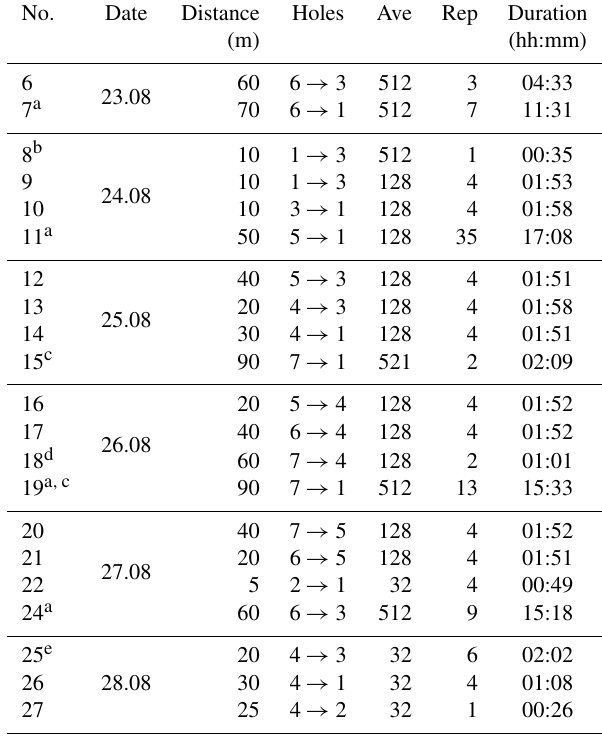
Table 2. After one full frequency scan, the full procedure is repeated several